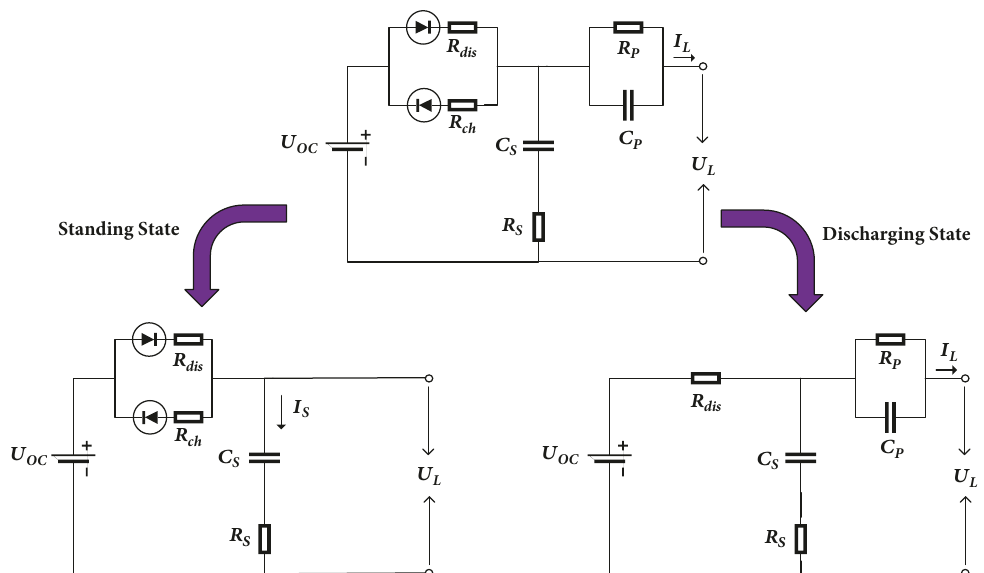
Figure 3: Lithium battery equivalent circuit model circuit